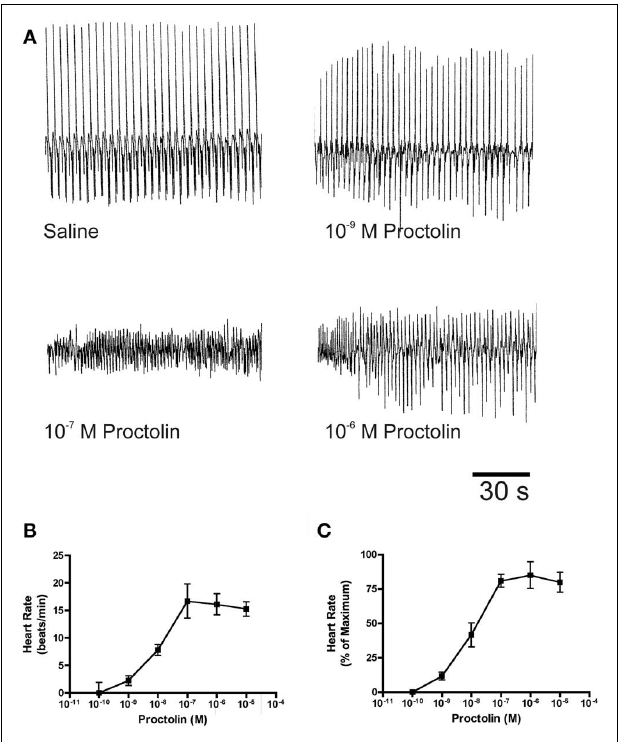
FIGURE 11 |The effects of 10 − 7 M proctolin and 10 − 7 M CCAP on the hindgut contraction of fifth instar R. prolixus . (A) Peptides added at upward arrow and vigorously washed with saline at downward arrow. (B) Histogram showing that CCAP is more effective than proctolin at inducing contraction at 10 − 7 M ( p < 0.001, Student’s t -test). Data are mean ± SE, n =